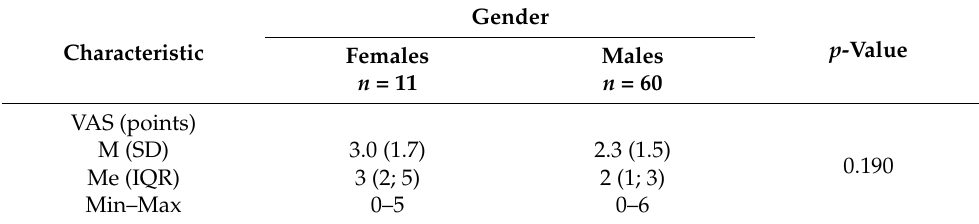
Table 3. Pain sensation on the VAS scale in groups of patients of different sex.